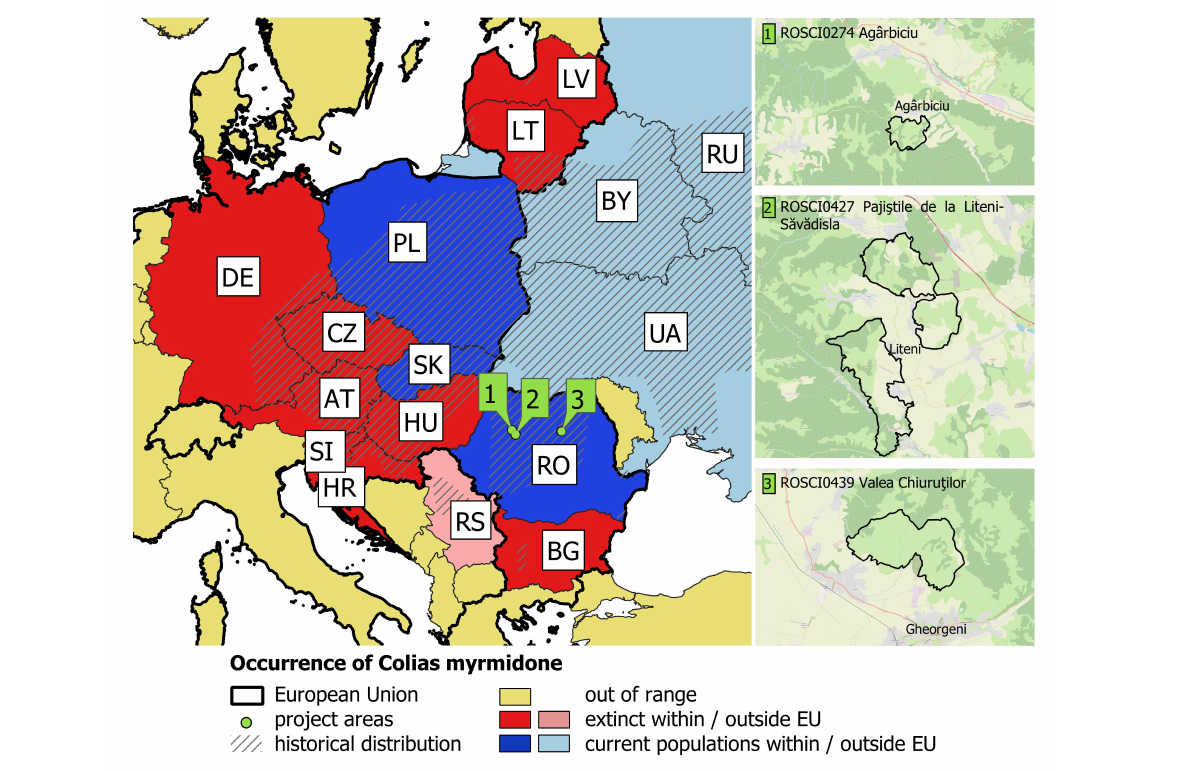
Fig. 1. Overview of past and current occurrences of Colias myrmidone (left); and project areas in Romania (right). Hatched area of distribution roughly according to Marhoul and Dolek (2012) and Kudrna et al.